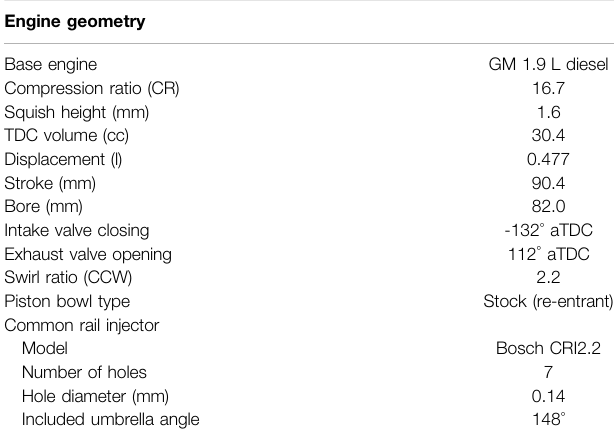
TABLE 1 | General motors 1.9 L single-cylinder engine & fuel injector speci fi cations. Engine geometry